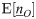
Perturbation analysis of lattice structure.(A) Dominant (top) and subdominant (bottom) eigenmodes for six variations of cluster (6) in Fig 5. In clusters (A1)-(A4), channels are progressively removed from left to right along the row indicated by the dashed line on the baseline cluster. (B) Values of eigenmode weights c
i as the channels are removed. (C) Removal of a single channel indicated by the arrows caused varying reductions in λ
1 depending on its position. The change in λ
1 compared to the baseline cluster (Δλ
1) is shown for each cluster (C1)-(C4). Heatmaps show E[n¯O] in each case. (D) Change in λ
1 when removing a single channel j from the baseline cluster. (v¯1)j is the channel’s corresponding element in the dominant eigenvector (red) and (E[n¯O])j is its element in E[n¯O] (blue) in the baseline cluster. Δλ
1 is again the change in λ
1 upon removing channel j. Heatmap color scales are the same as in Fig 4D.